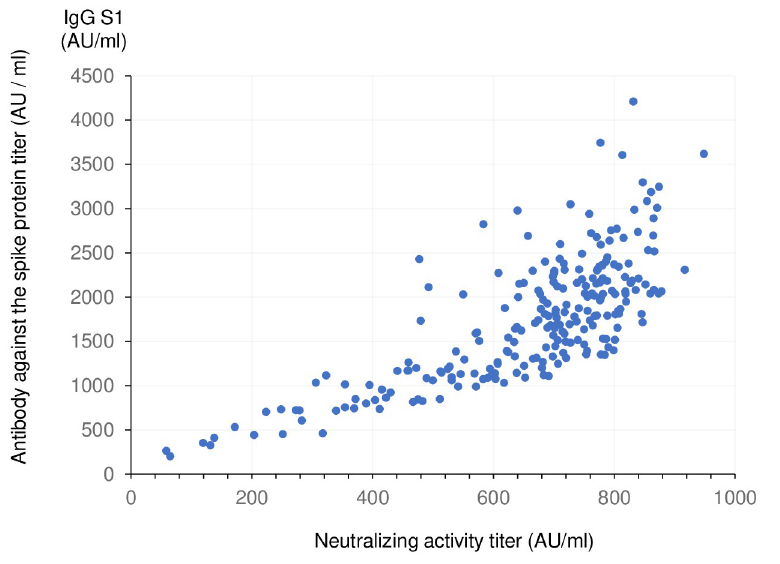
Fig 1. Anti-SARS-CoV-2 spike protein antibody titer and neutralizing activity.